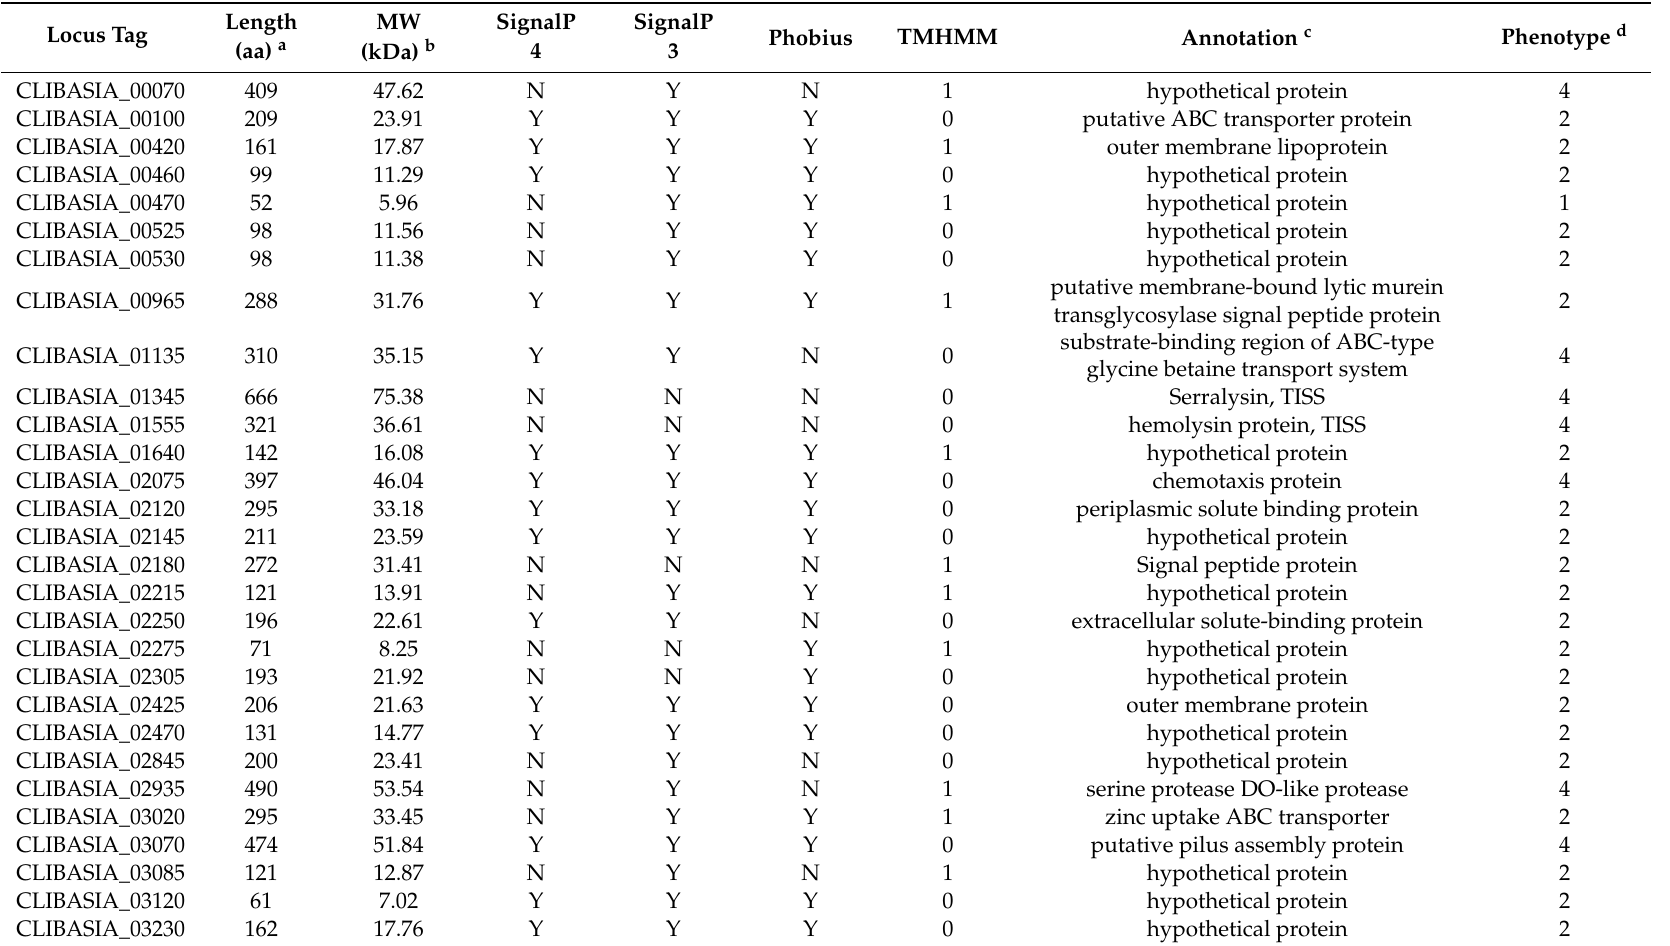
Table 1. The selected putative virulence factors of Ca Las and the phenotypes of N. benthamiana expressing the putative virulence factors. Locus